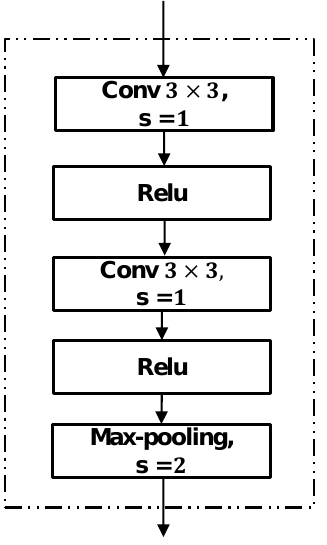
Figure 3. Architecture of the added feature extraction block to generate multi-scale output